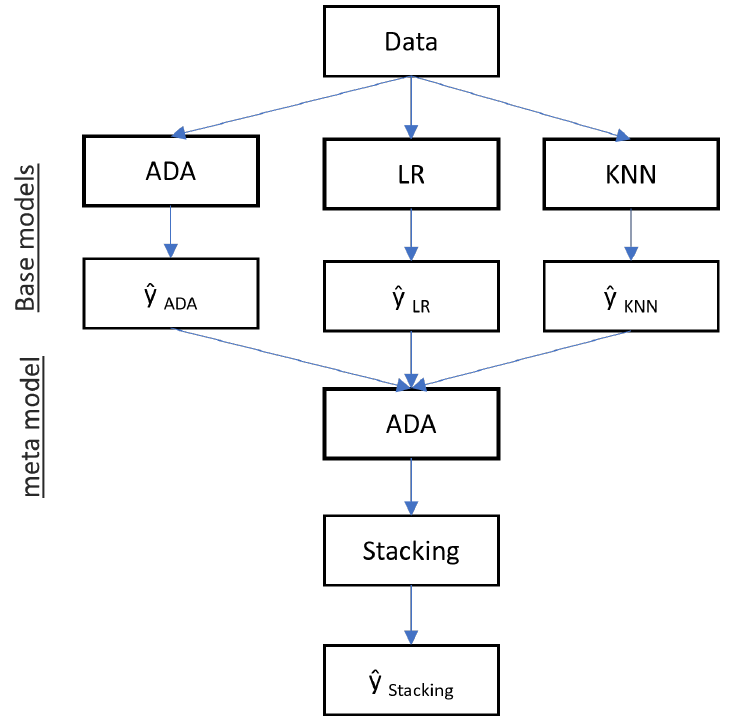
Figure 2. Stacking ensemble classifier model.